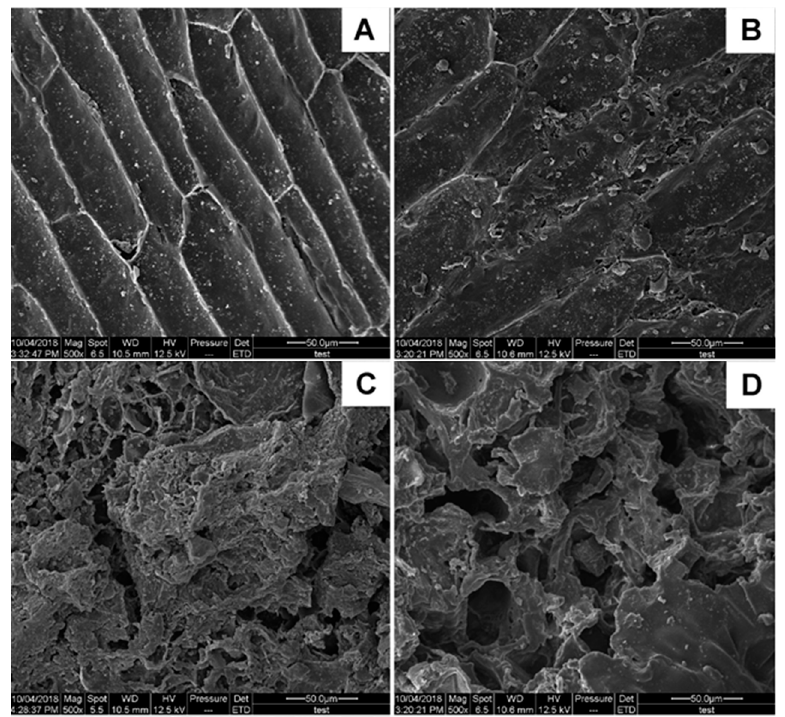
Figure 7. SEM images of Mairei Yew leaves samples. ( A ) is raw materials; ( B – D ) are, respectively, samples after HRE, UAE and UHRE.